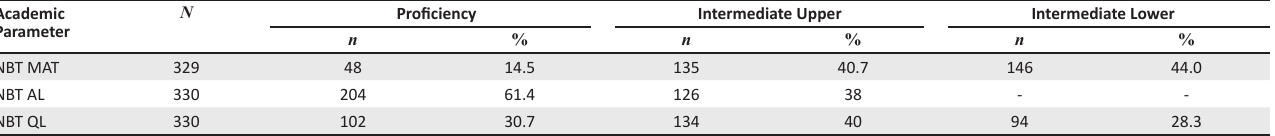
TABLE 4: National Benchmark Test domains of the cohort (2013–2017). Academic Parameter